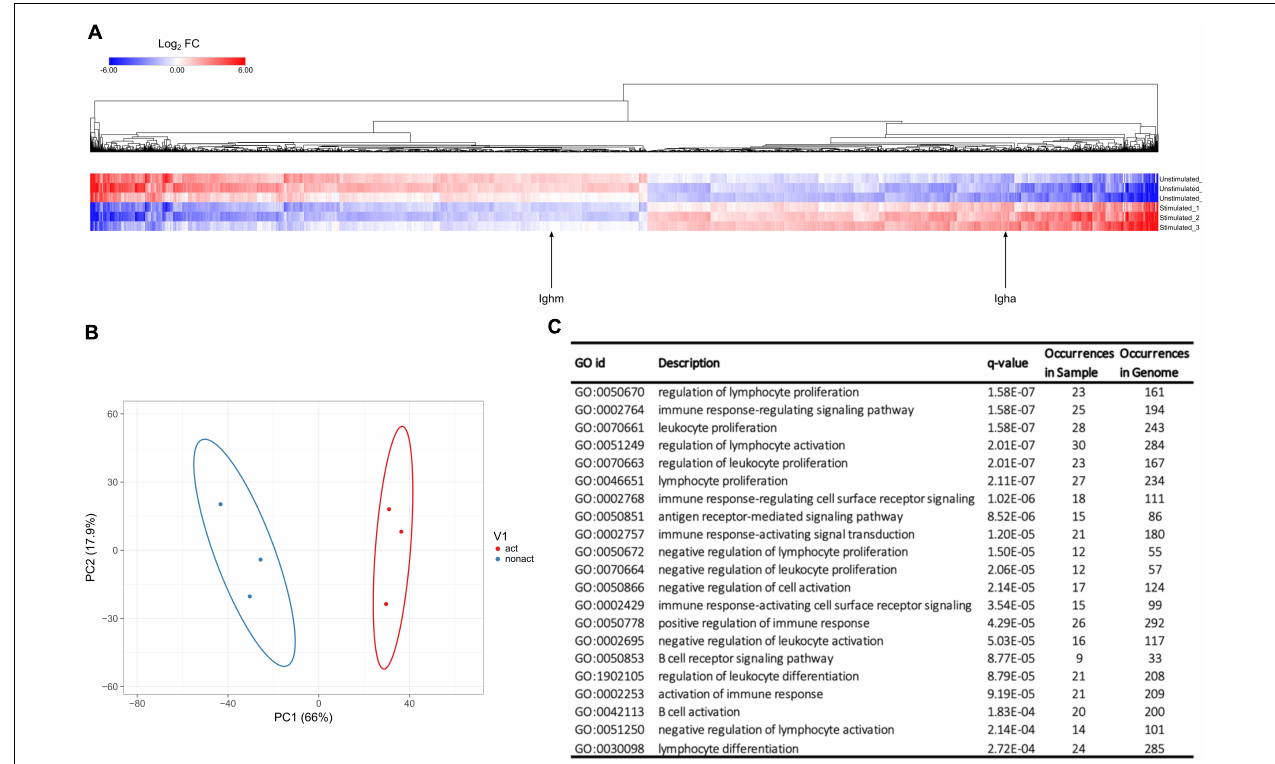
FIGURE 3 | Transcriptomes of D0 and D4 cells. (A) Heatmap of the log2 fold change of transcripts from D0 and D4 samples, calculated using the DESeq2 software. Transcripts with | log2 fold change| > 0.5 and FDR < 0.05 are shown. Two transcripts, Ighm and Igha , are highlighted. Ighm and Igha code for the immunoglobulin heavy chain constant regions of IgM and IgA receptors, respectively. (B) PCA analysis showing separation of D0 and D4 samples. (C) Functional enrichment analysis of differentially expressed transcripts between D0 and D4. Table displaying significantly enriched gene ontology (GO) terms and associated biological processes.